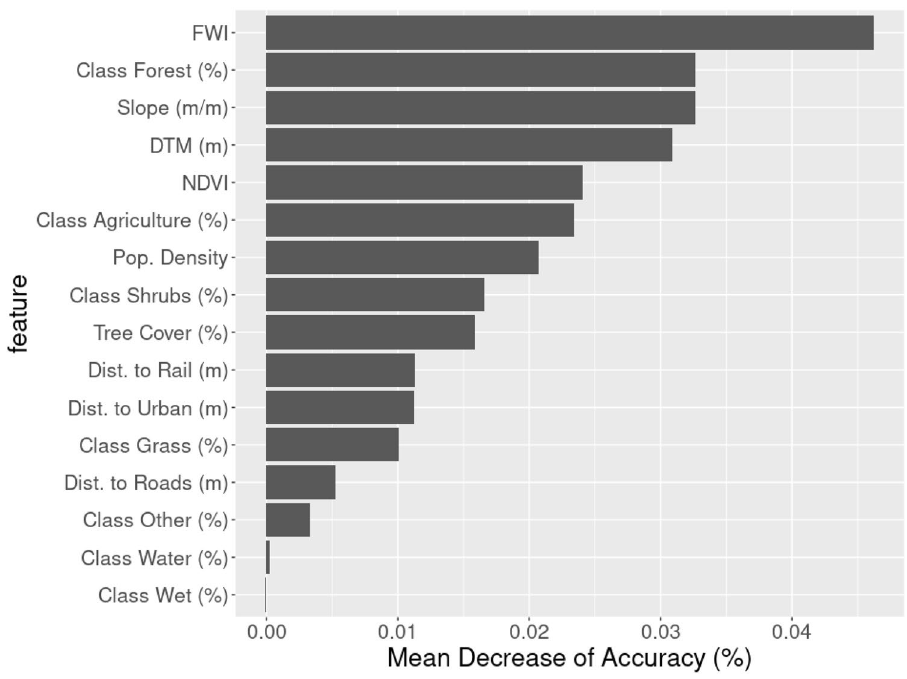
Figure 4. Feature importance embedded in the Random Forest model in terms of mean decrease in